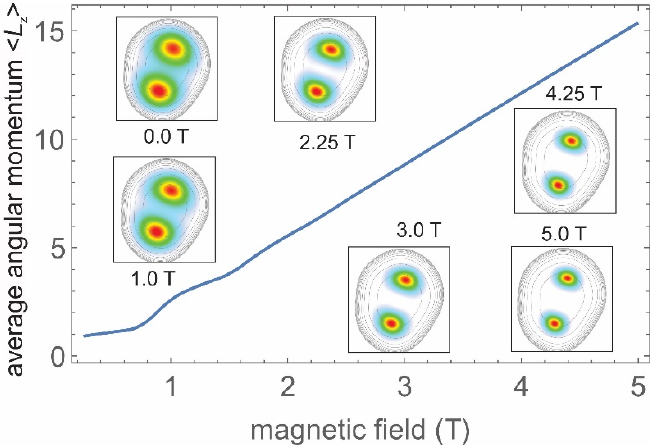
Figure 3. Average orbital angular momentum 〈(cid:1838) (cid:3053) 〉 calculated for the ground state of an InP/GaInP 2 QD having r s = 4.3. The inserts are densities for (cid:1828) = 0 T, 1 T, and up to 5 T in the 200x200 nm 2 frame. The contours indicate the deformed confining